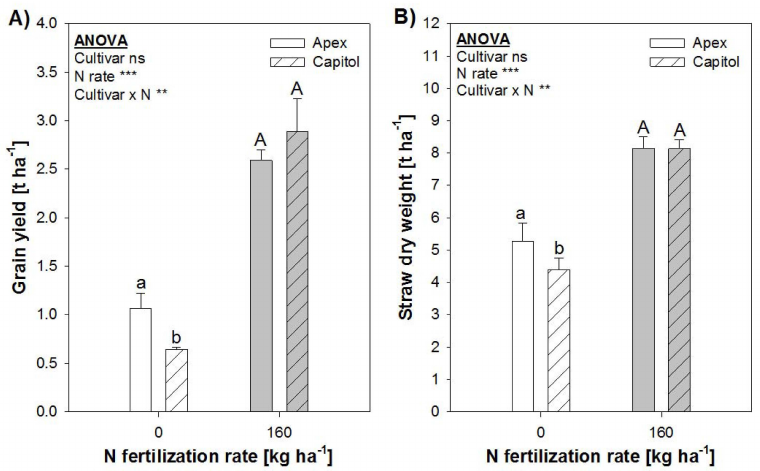
Figure 2. ( A ) Grain yield and ( B ) straw dry weight at maturity of the winter oilseed-rape line-cultivars Apex and Capitol as affected by the N fertilization rate (N0 and N160). Different lower case and upper case letters on the top of the columns indicate differences between the cultivars within the N fertilizer rates at p < 0.05. ANOVA: ** and *** indicate significant differences at p < 0.01 and p < 0.001, respectively. ns = non-significant. The error bars represent the standard deviations of the means ( n = 3–4).